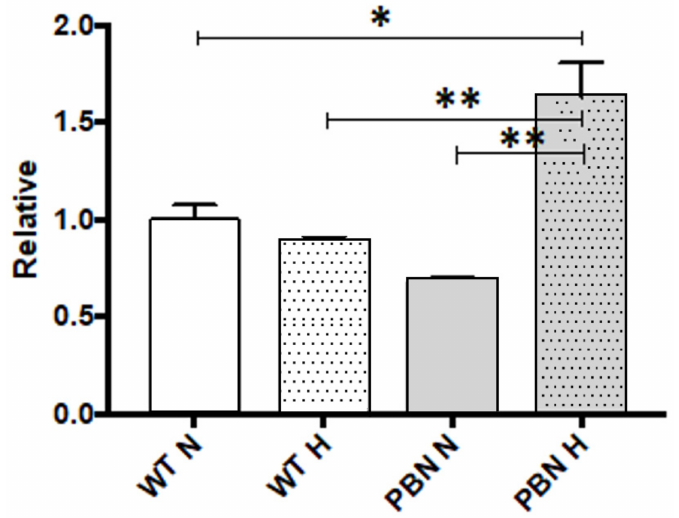
Figure 7. Relative length of SkMDS/PCs telomeres in PBN-treated cell populations: WT= wild-type SkMDS/PCs, PBN-SkMDS/PCs preconditioned with PBN under standard (N) and hypoxic (H) culture conditions. Abbreviations: SkMDS/PCs = skeletal muscle derived stem/progenitor cells; WT = wild-type non-treated SkMDS/PCs; PBN = SkMDS/PCs cultured in medium conditioned with tert-butyl-alpha-phenyl nitrone. * significant at p value < 0.05, ** significant at p value <